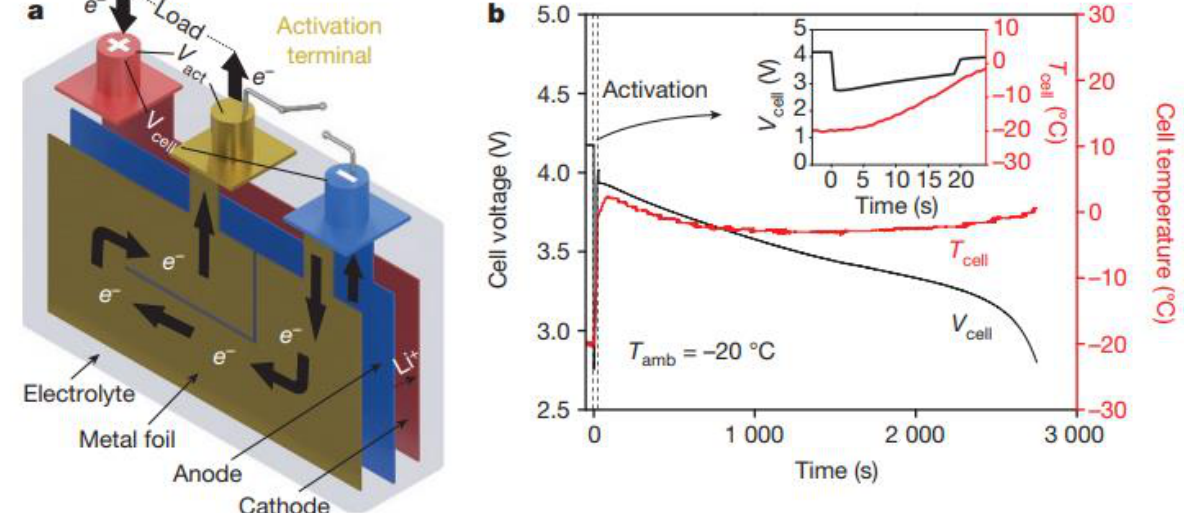
Figure 23. ( a ) In situ thermal management concept designed on an internally installed metal foil that can produce heat at low temperature using controlled self-heating. ( b ) Transient profile of temperature and discharge voltage during the activation. Reprinted with permission from [167].